Question: Which visualization type does this figure use?
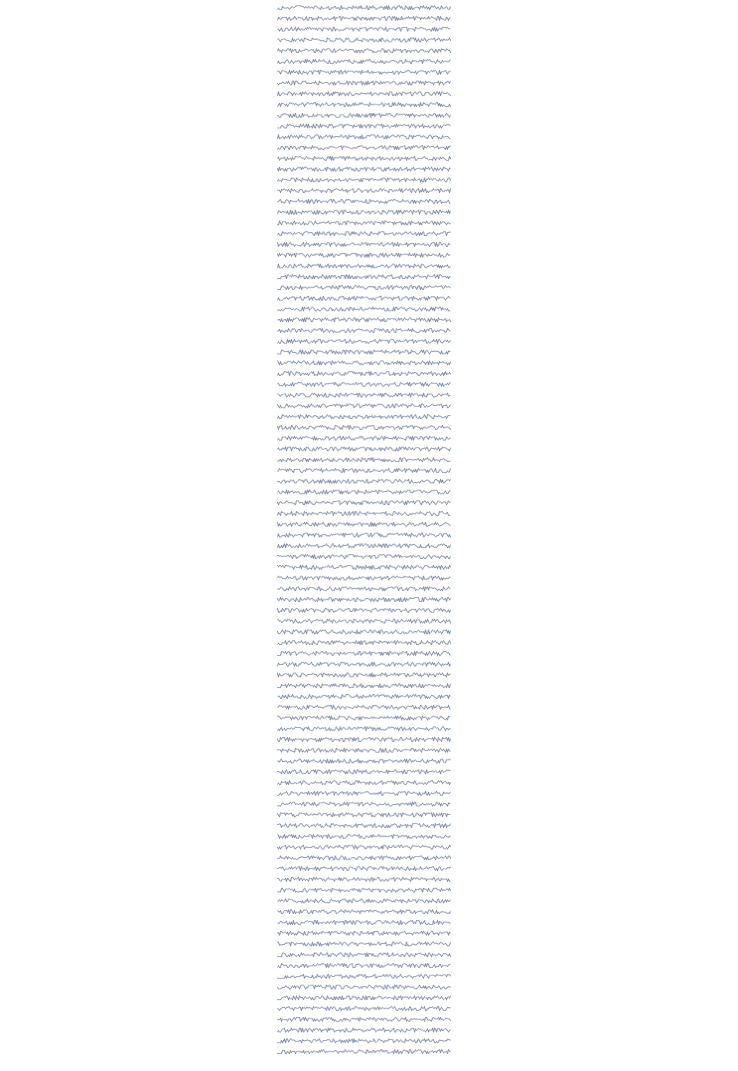
Answer: line